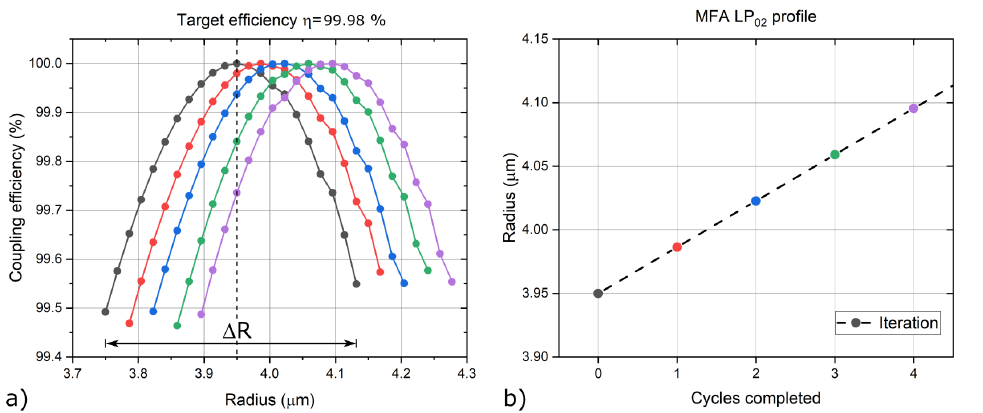
Figure 3. Analysis of the diameter variation aiming to match the target waveguide. ( a ) Coupling efficiencies while varying the diameter within a defined span, taking as starting point different diameters (each color trace represents the possible coupling efficiencies for every iteration). ( b ) First points of mode field adapter profile designed for the LP 02